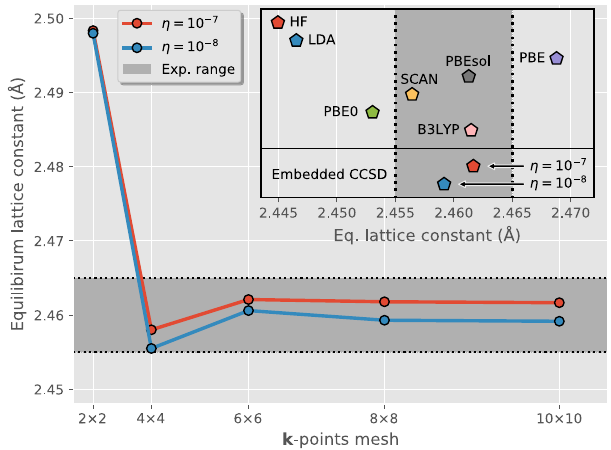
FIG. 5. Equilibrium lattice constant of graphene calculated with embedded CCSD for two different bath thresholds, η ¼ 10 − 7 and η ¼ 10 − 8 . Inset: comparison of the embedded CCSD results with HF and DFT calculations using a 10 × 10 k -point sampling. PBEsol refers to the modified PBE functional of Ref. [70]. The gray stripes indicate the experimental range in both plots. All calculations are performed with the def2-TZVP basis